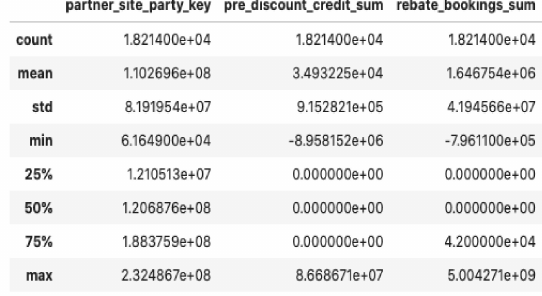
Figure 9. Quantitative analysis of the data.